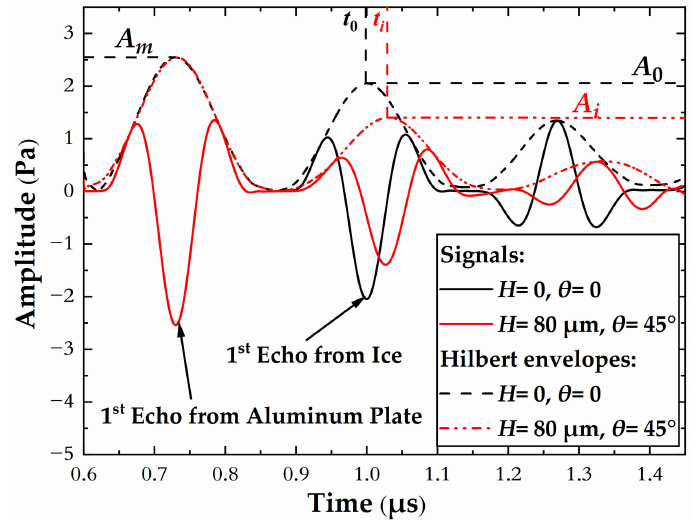
Figure 4. Radiofrequency echo signals (solid lines) with their envelopes (dashed lines) for an ice layer of thickness 0.5 mm. The black lines are for standard signals without roughness profiles, and the red lines are for a roughness height and a contact angle of 80 µ m and 45 ◦ ,